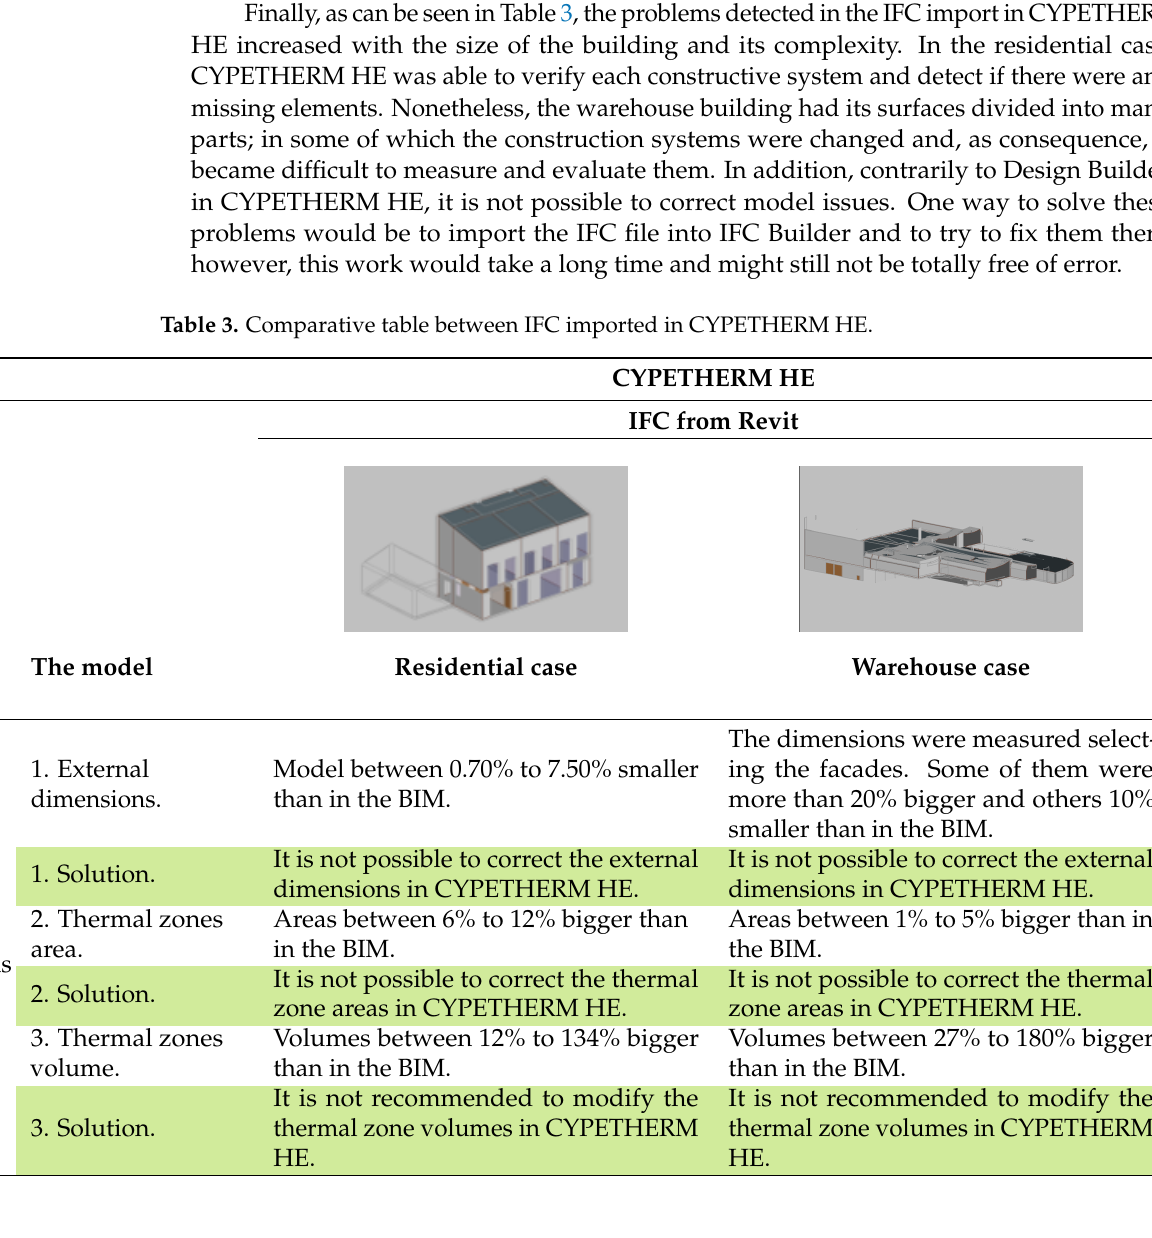
Figure 9. Residential and warehouse industry foundation classes (IFC) files imported in CYPETHERM HE.